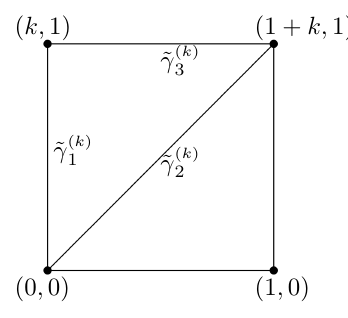
Figure 13 . Triangulation after k unflips of Π γ 1 ,γ 2